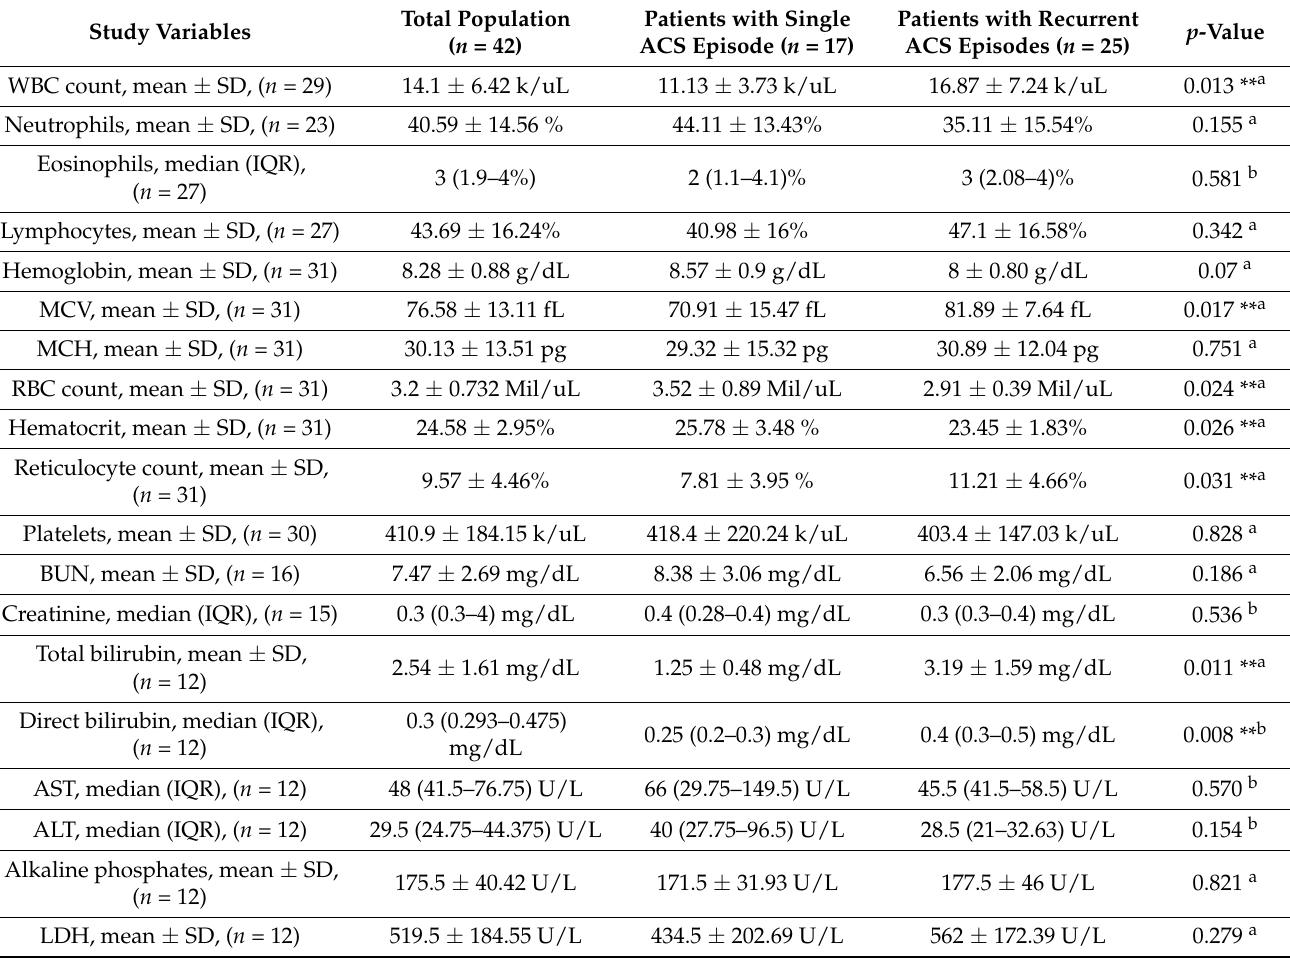
Table 3. Baseline laboratory data of the included patients ( n =